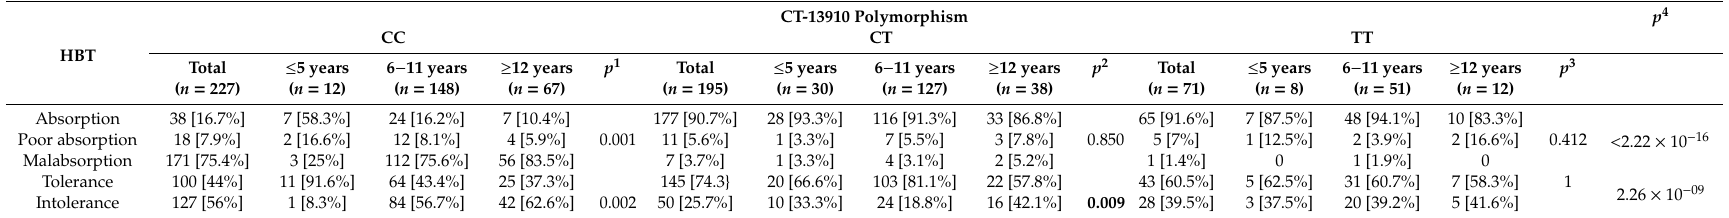
Table 3. C / T-13190 polymorphism and HBT according to age. Genotype-phenotype